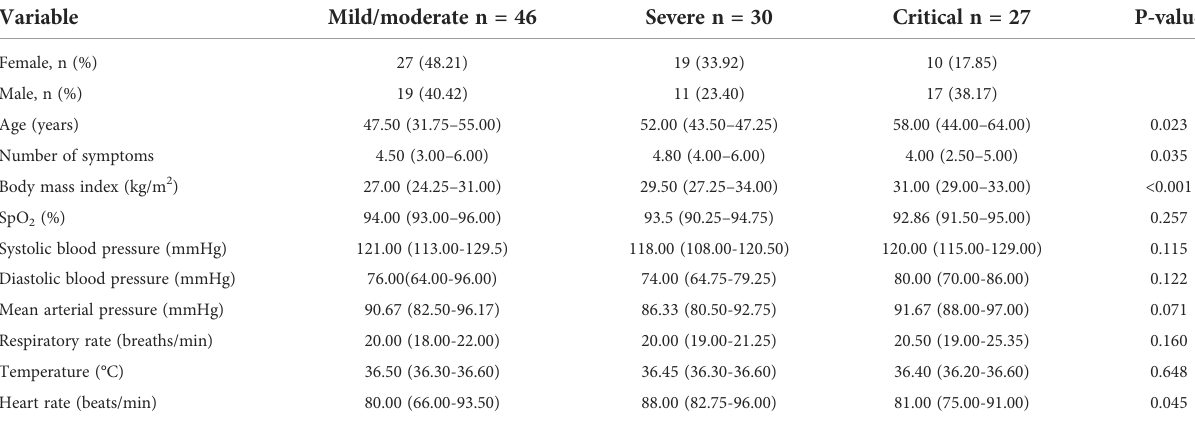
TABLE 1 Clinical characteristics of patients with mild to critical COVID-19 at recruitment.